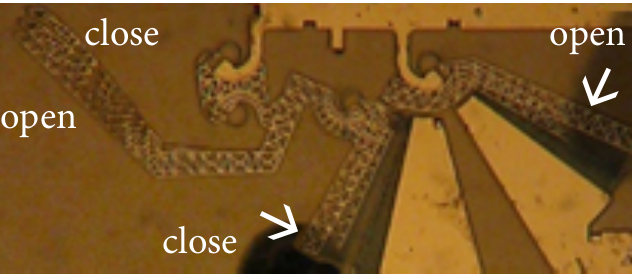
Figure 4. Overlapping images of the microgripper in close, neutral, and open